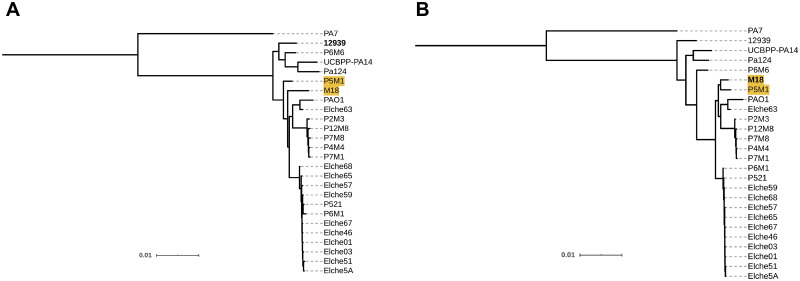
Impact of reference choice on phylogenetic trees of P. aeruginosa.ML trees included the selected reference sequences of P. aeruginosa and the consensus sequences obtained from mappings against strains (A) M18 and (B) 12939. Reference M18 and isolate P5M1 (yellow) alter their phylogenetic relationships depending on reference choice.